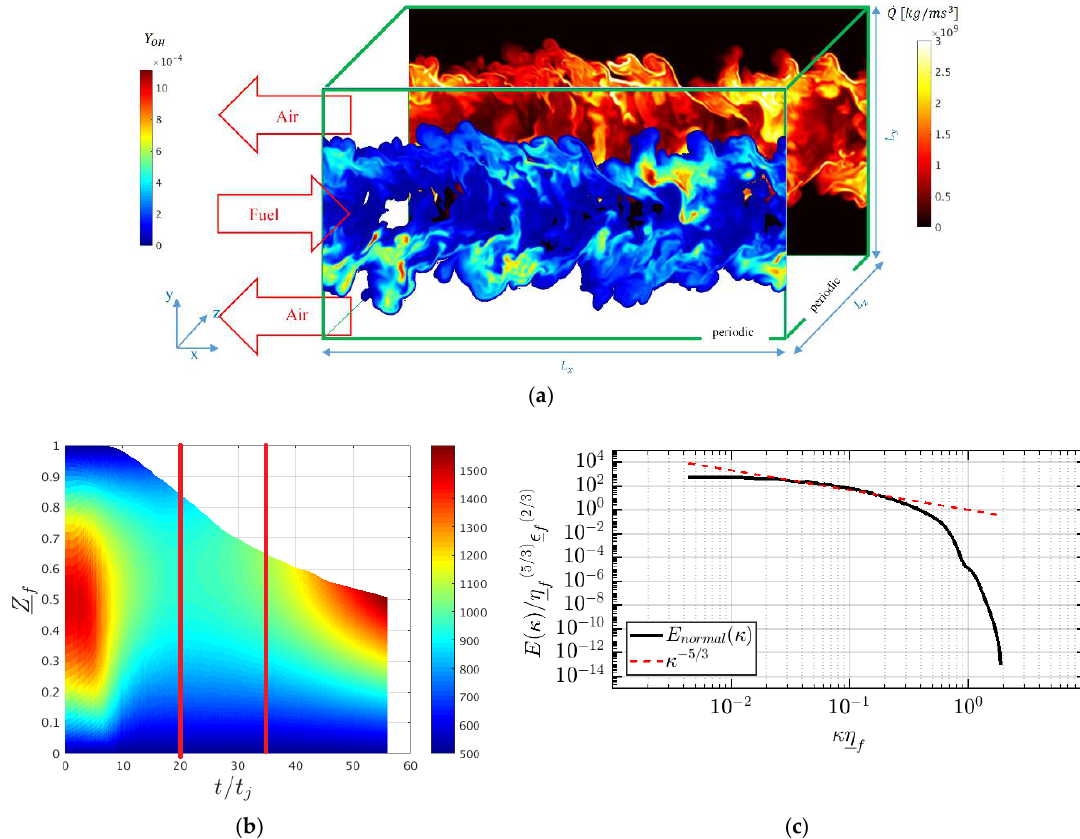
Figure 1. ( a ) The schematic of the temporal jet direct numerical simulation (DNS) case, including the contours of heat release rate (colored from black to white) and the mass fraction of OH radical (colored from blue to red) at the maximum extinction time ( 𝑡 = 20𝑡 𝑗 ). Local extinction events on the shear layers are observed with low OH mass fraction and the corresponding low heat release rate; ( b ) favre averaged mixture fraction ( 𝑍 𝑓 ) in the whole simulation time colored by Favre averaged temperature. The vertical red lines are the time instants analyzed in the current study; and ( c ) normalized energy spectrum on the center plane (black line) and −5/3 scaling law shown by dashed red line; 𝜅 is the wave number, 𝜂 𝑓 , Favre averaged Kolmogorov length scale and 𝜀 𝑓 Favre averaged turbulent dissipation rate.